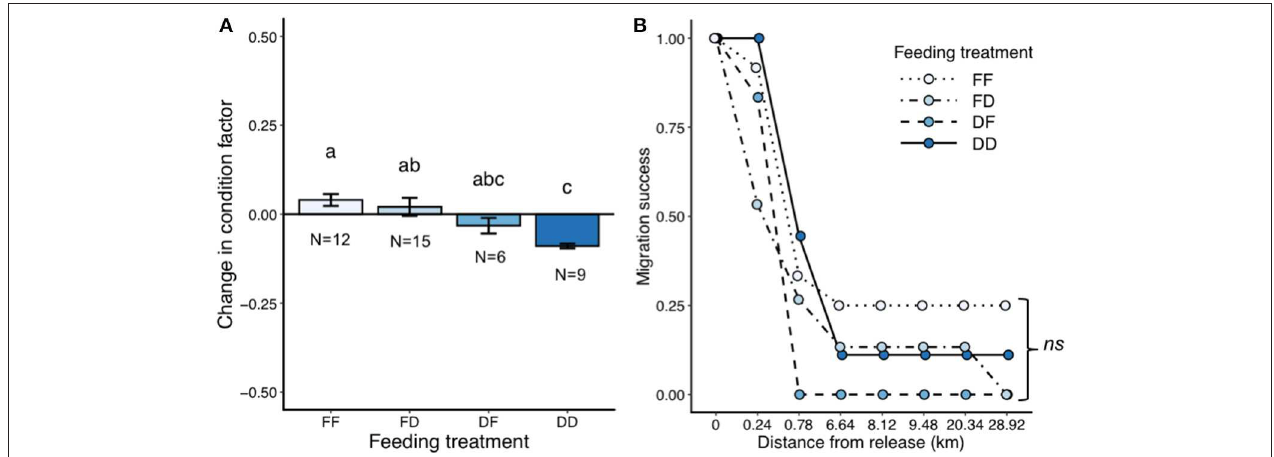
FIGURE 6 | Results from the large-scale field migration study (part three), showing change in condition factor (A) and migration success in the field (B) . Error bars represent ± 1 standard error of the mean. Different letters show statistical differences among treatment groups. Note: only age two fish were used in this